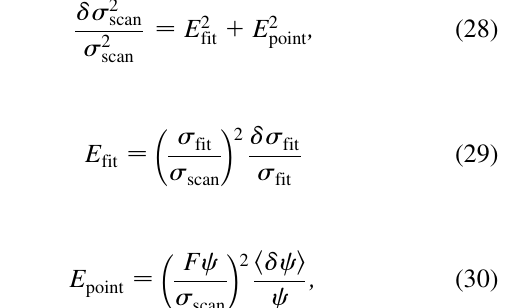
) for the measurement stat